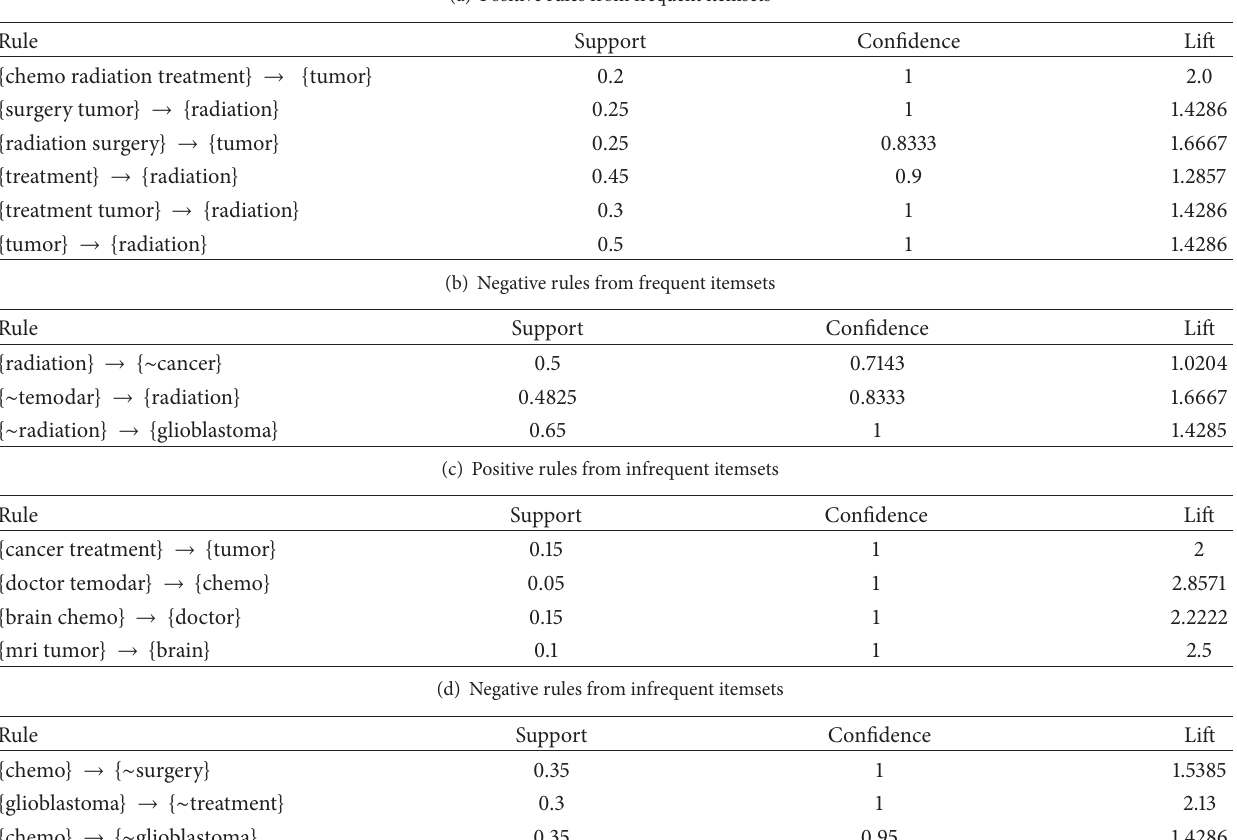
Table 4: Positive and negative rules from both frequent and infrequent